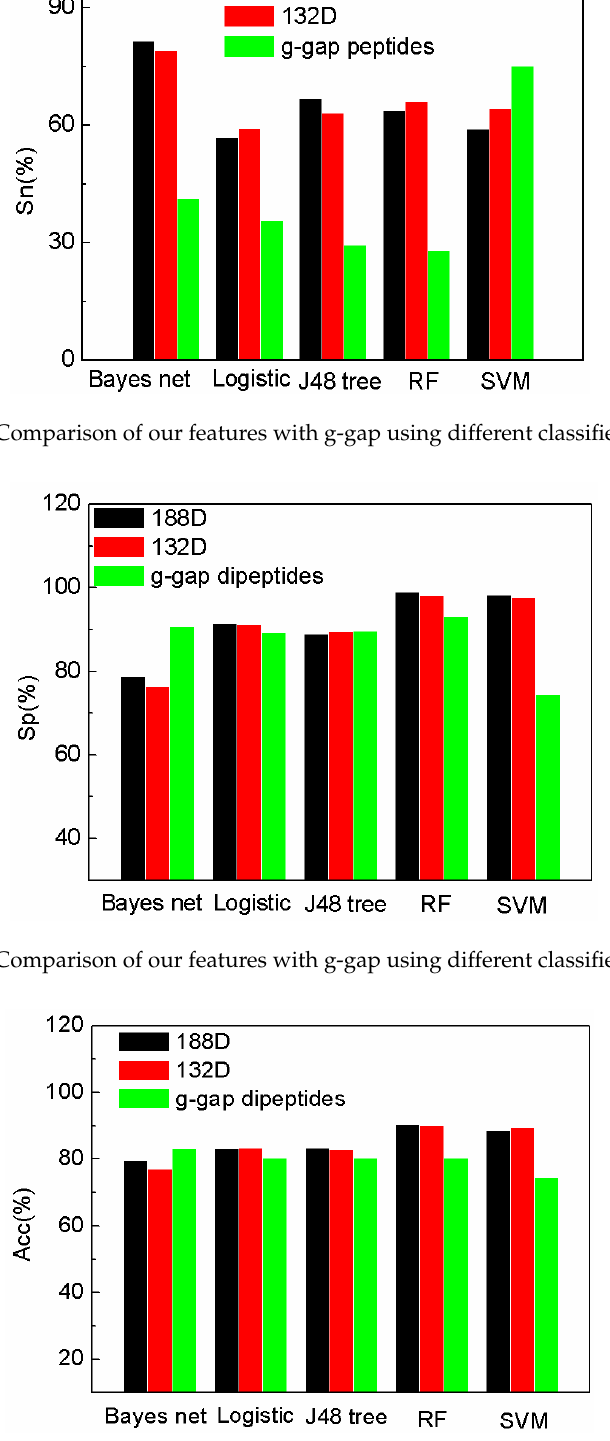
Figure 3. Comparison of our features with g-gap using different classifiers on Acc.